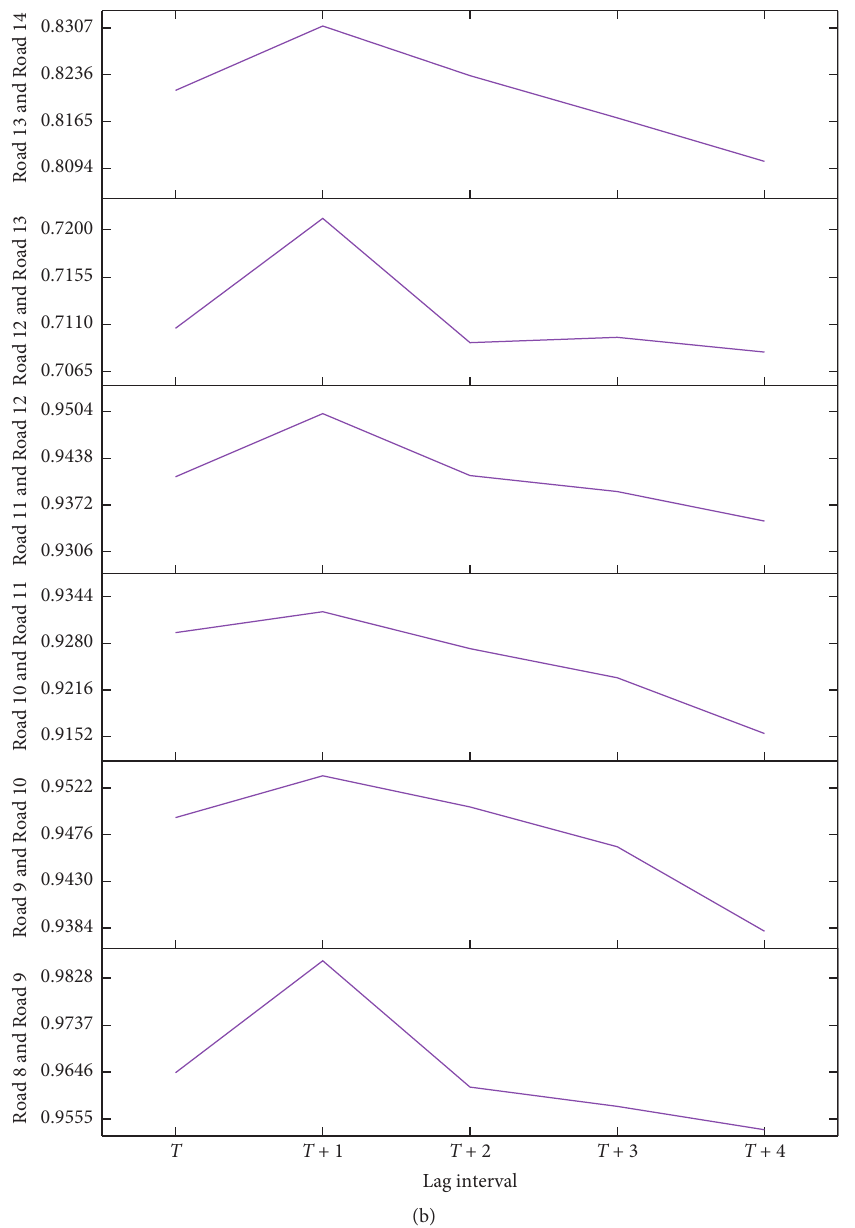
Figure 4: Pearson correlation results of up-direction and